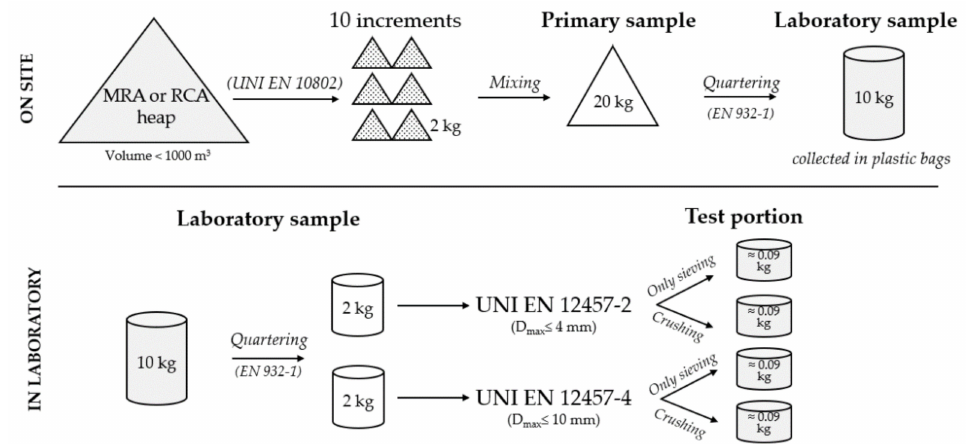
Figure 3. Scheme of the RA sampling method adopted.